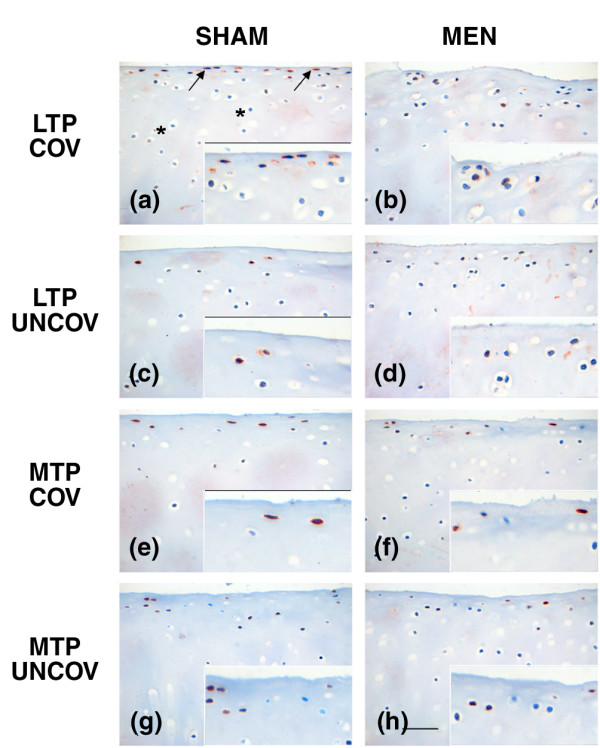
Regional immunolocalisation of proteoglycan 4 (PRG4) with polyclonal antibody 06A10 in ovine tibial plateau cartilage. Lateral and medial tibial plateaux (LTP and MTP, respectively) from regions covered (COV) or uncovered (UNCOV) by the meniscus in sham-operated and meniscectomised (MEN) joints are shown, including enlarged views of respective surface zones as insets. Representative PRG4-positive (arrows) and PRG4-negative (asterisks) chondrocytes are indicated. Scale bar, 150 μm.